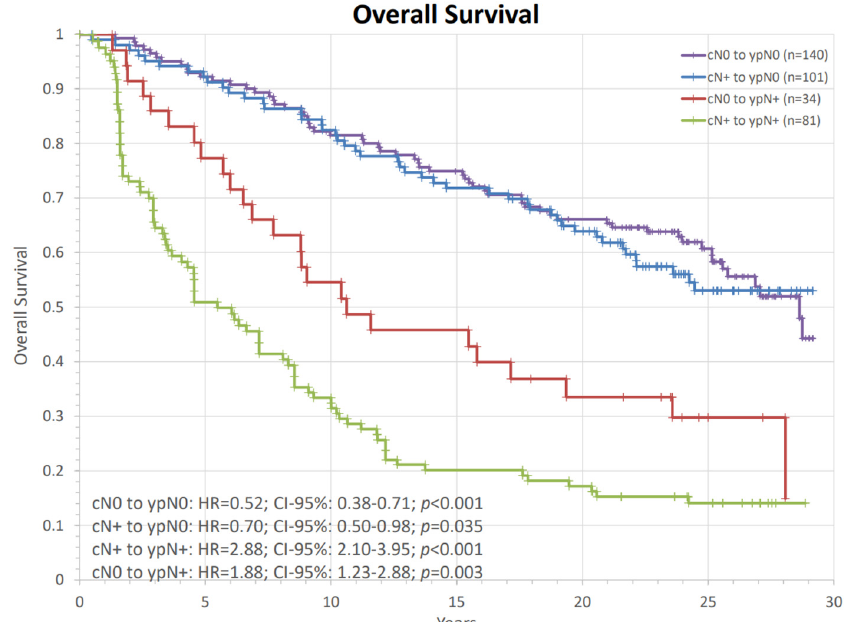
Figure 6. Analysis of the impact of clinical and pathological nodal status on overall survival. The comparisons of each group are set against the remaining patients in the whole cohort and are presented with hazard ratios and their corresponding confidence intervals and p -values. HR: hazard ratio, ypT: postoperative primary tumor stage, ypN: postoperative nodal stage, CI: confidence interval, pCR: pathological complete response, n: number of patients.